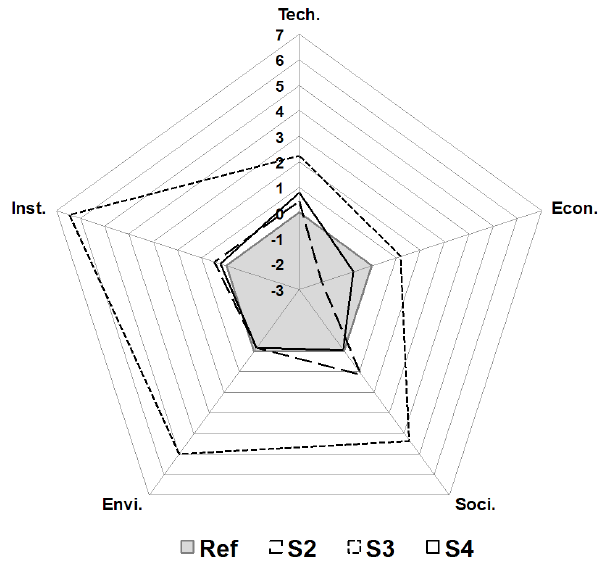
Figure 4. Graphical comparison of the sustainability profiles (source: